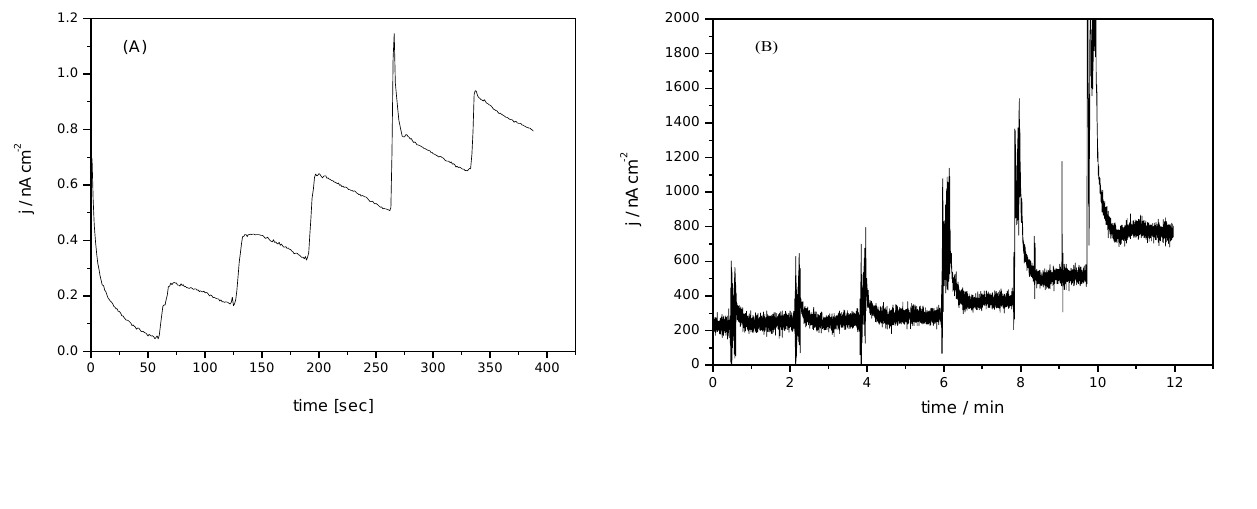
Figure 5. CPA recoded at ( A ) M-SZ-GEC in 50 mM PBS supporting electrolyte with adding 500 µM AA followed by increasing concentrations of Dopamine: 10 µM, 20 µM, 30 µM, 40 µM, 50 µM, Pt reference electrode and Ag/AgCl auxiliary electrode; Potential value of +0.100 V; ( B ) CPA recoded at SZ-GEC microelectrode without Nafion film in 20 mL of 50 mM PBS supporting electrolyte with increasing concentrations of Dopamine: 25 nM, 50 nM, 100 nM, 250 nM, 500 nM, 750 nM, 1 µM; Pt reference electrode and Ag/AgCl auxiliary electrode; Potential value +0.150